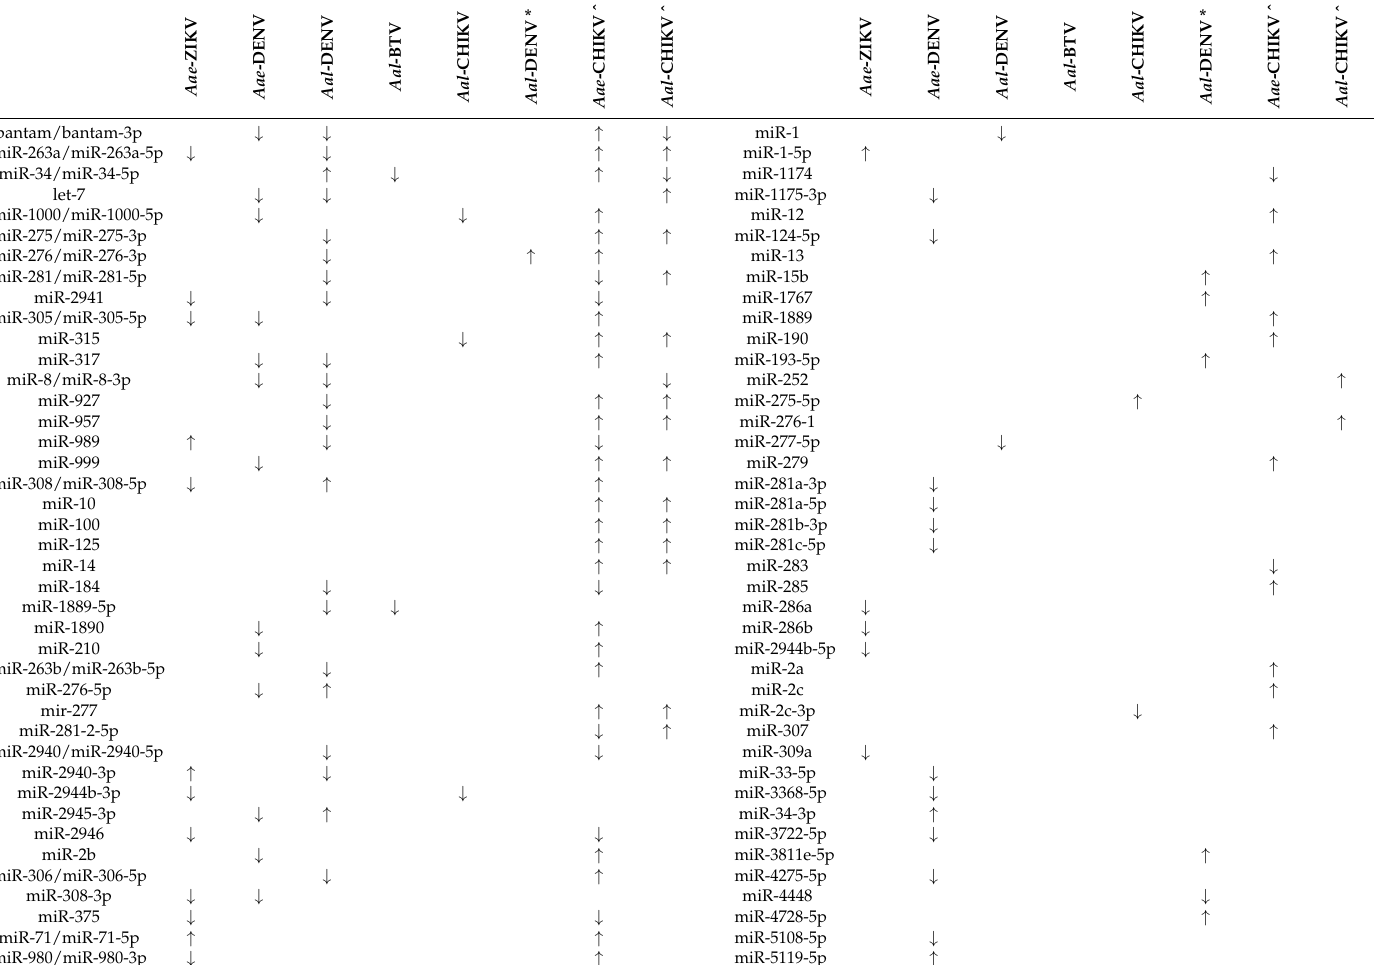
Table 2. NGS-quantified differential abundance of Aedes miRNAs during virus